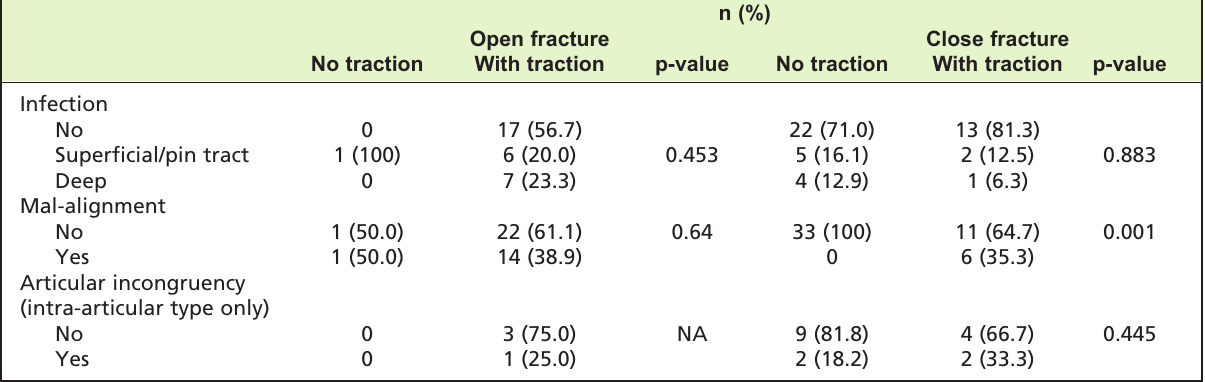
Comparison of outcome with or without skeletal traction or external fixator (n=91) Table IV: